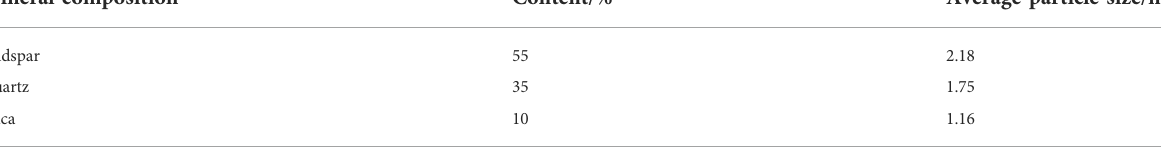
TABLE 2 Calibrated mineral content and grain size of granite. Mineral